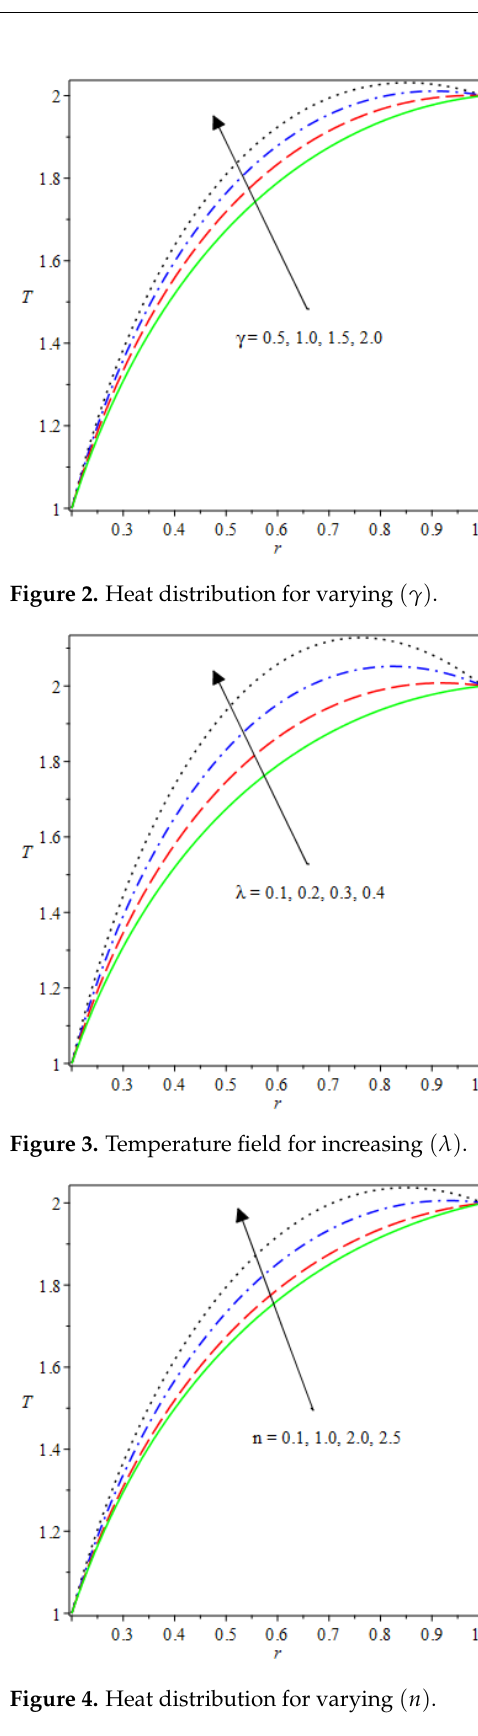
Figure 4. Heat distribution for varying ( n )